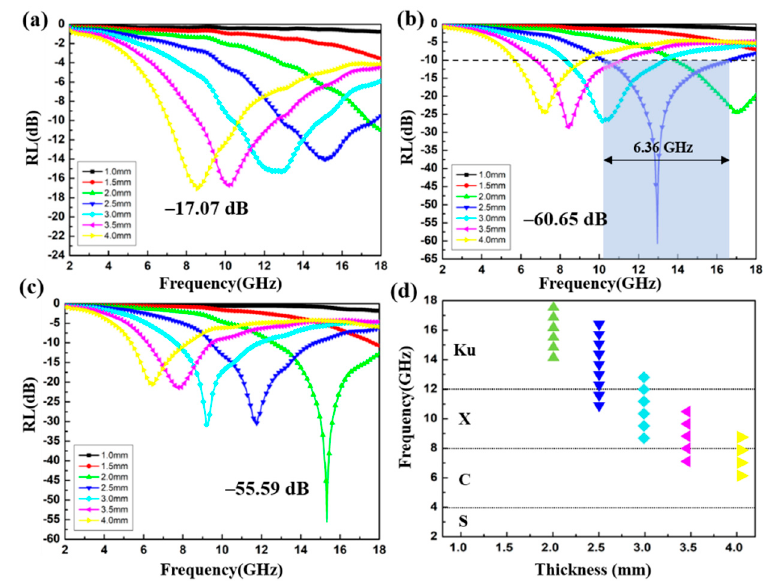
Figure 8. Cole–Cole plots of ( a ) S1, ( b ) S2, and ( c ) S3.